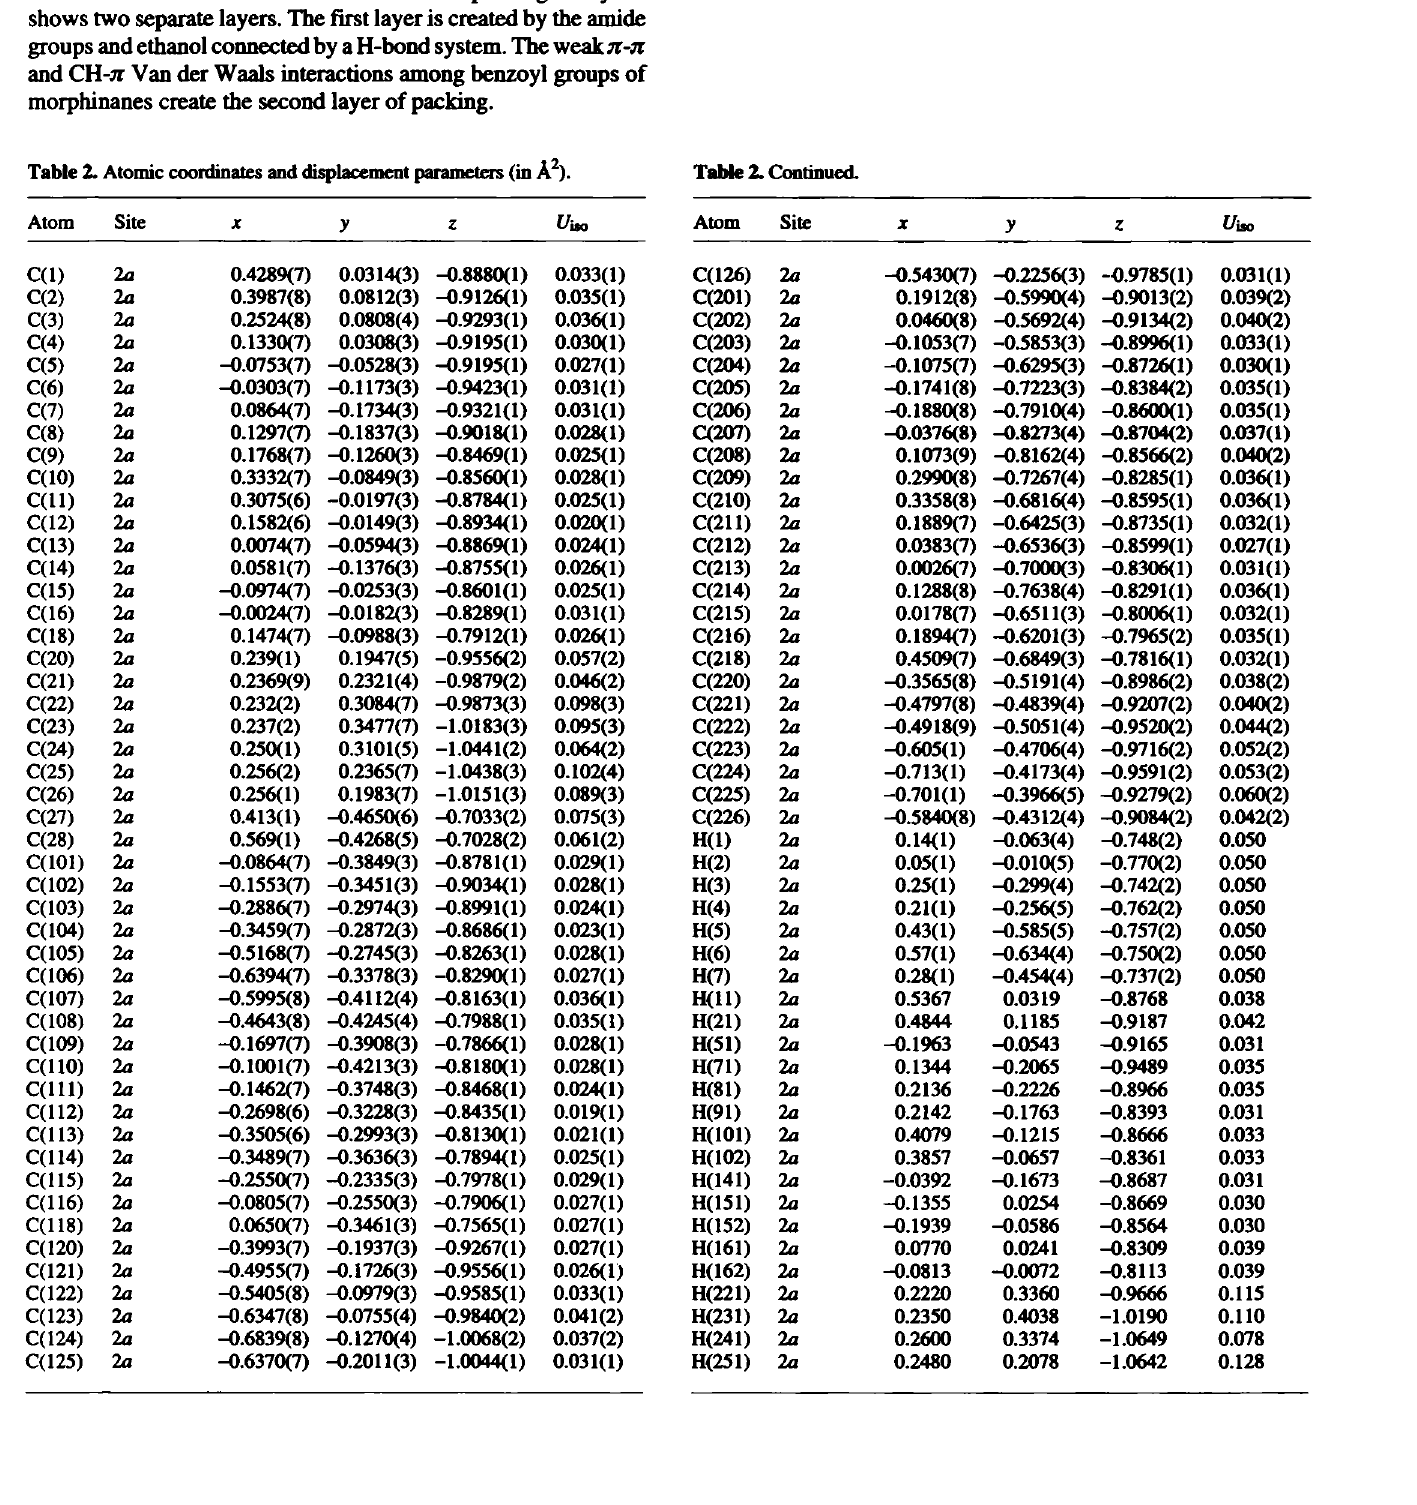
Table 2. Atomic coordinates and displacement parameters (in A 2 ).